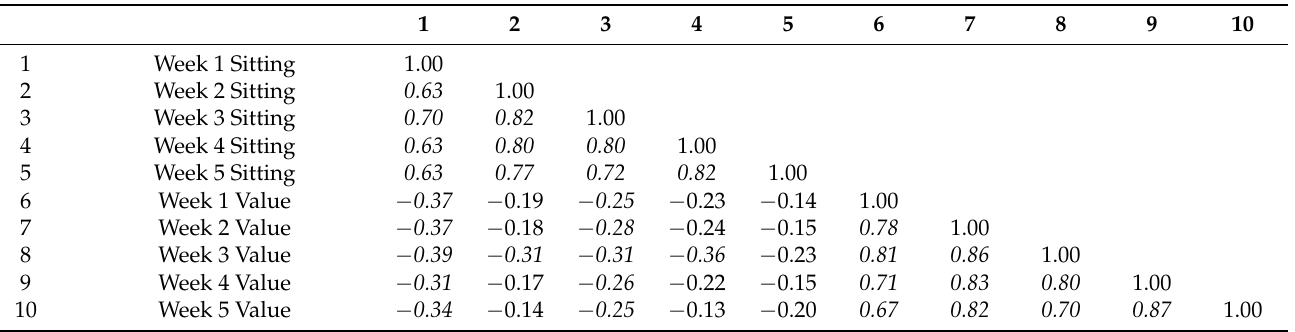
Table 2. Correlation estimates of weekly prolonged sitting and physical activity